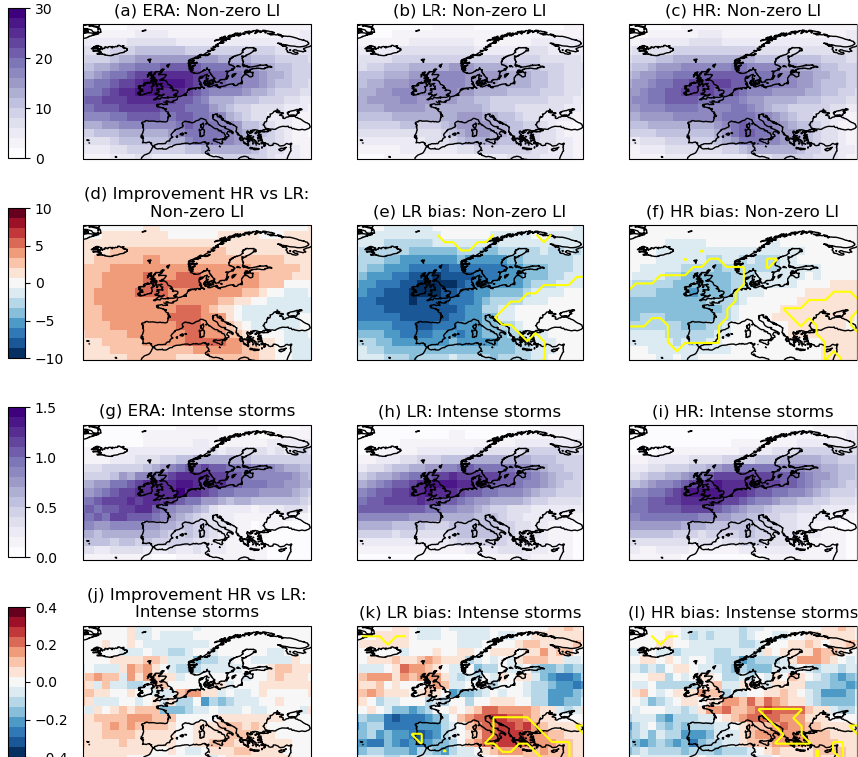
Figure 4. Track densities from re-analysis and PRIMAVERA models for tracks with a non-zero loss index (LI) and severe storms (LI > 1 × 10 6 ). Following Economou et al. (2015), track density is defined by the number of tracks with at least one track point passing within 6.3 ◦ of each grid box (on a 2.5 ◦ × 2.5 ◦ grid) per winter. The re-analysis track densities for non-zero LI storms are shown in (a) and severe storms in (g) . The track densities and bias (model – re-analysis) for the low-resolution PRIMAVERA models are shown in panels (b) and (e) for the non-zero LI storms ( h and k for the severe storms), as well as for the higher-resolution PRIMAVERA models in panels (c) and (f) ( i and l for the severe storms). The medium-resolution version of HadGEM3-GC3.1 is included in the higher-resolution models. The change in bias ( | low-resolution bias |−| high-resolution bias | ) from low to high resolution is shown in panel (d) for the non-zero LI storms and in (j) for the severe storms, with red areas corresponding to improvement with increased resolution. The yellow contour marks where the bias is statistically different from 0 with 95% confidence according to Welch’s unequal variances t